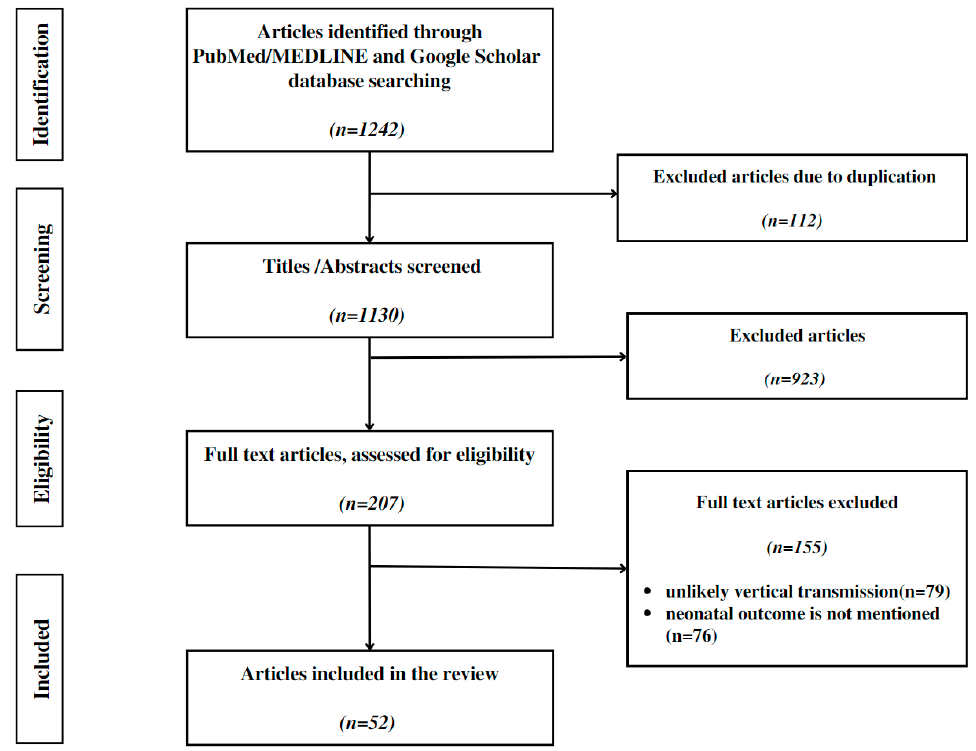
Figure 2. Flow chart of the review process, according to the PRISMA ScR guidelines.